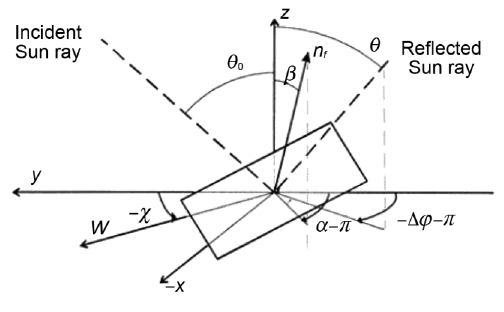
Fig. 4. Sun glint geometry: i 0 is the solar zenith angle, i is the sensor zenith angle, ∆ { is difference between the solar and sensor azimuth angles, a and b are the facet azimuth and zenith angle respective- ly, W is the wind speed module and | is the wind di- rection (Montagner and Billat,